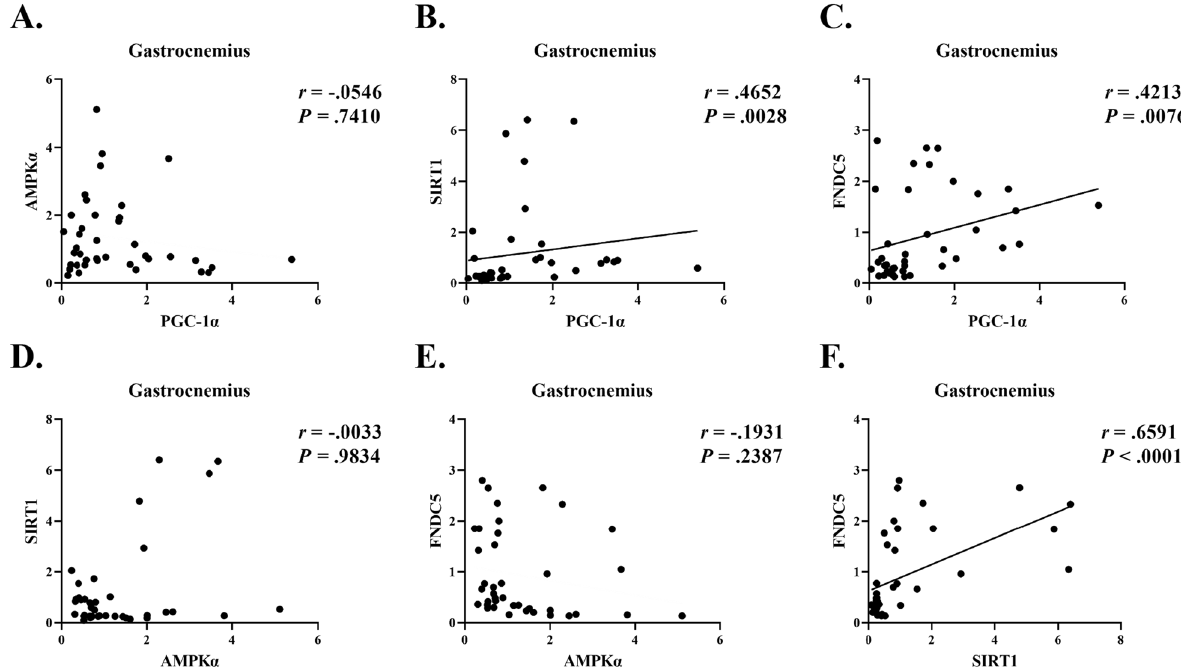
Fig. 6 Correlation analysis between expressed proteins in the gastrocnemius